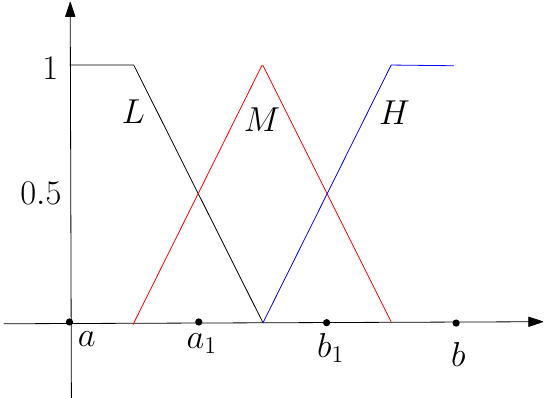
Figure 3. The membership functions of the fuzzy numbers related to a variable x